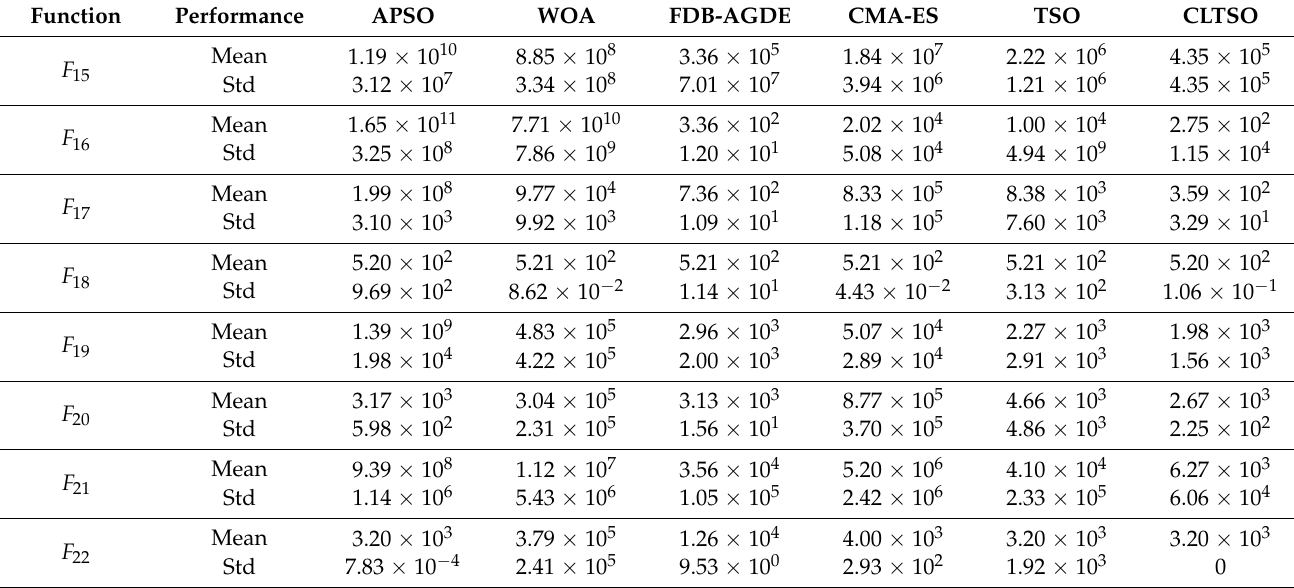
Table 6. Simulation results of CEC2014